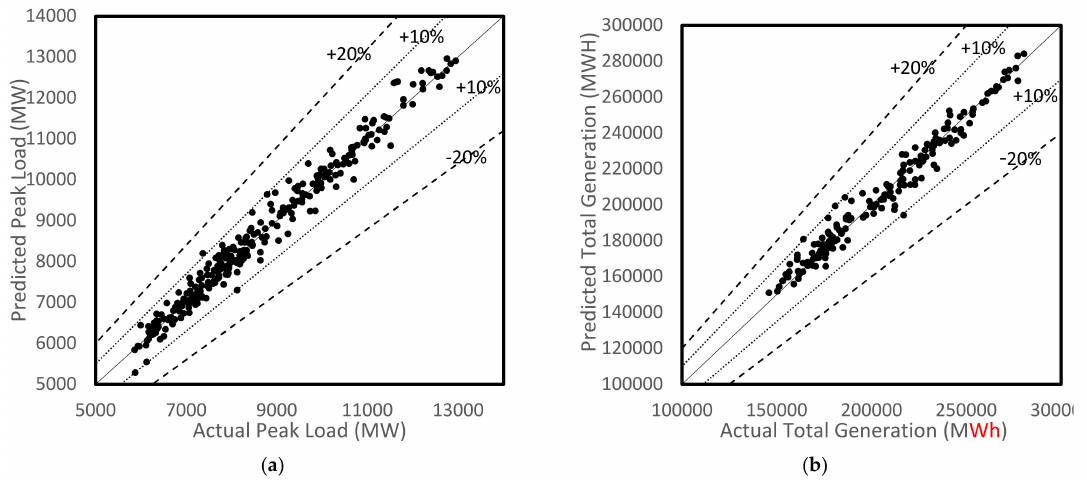
Figure 4. Comparison obtained through regression analysis and actual data recorded for March, April and May for 2017 to 2019, ( a ) peak load, and ( b ) total